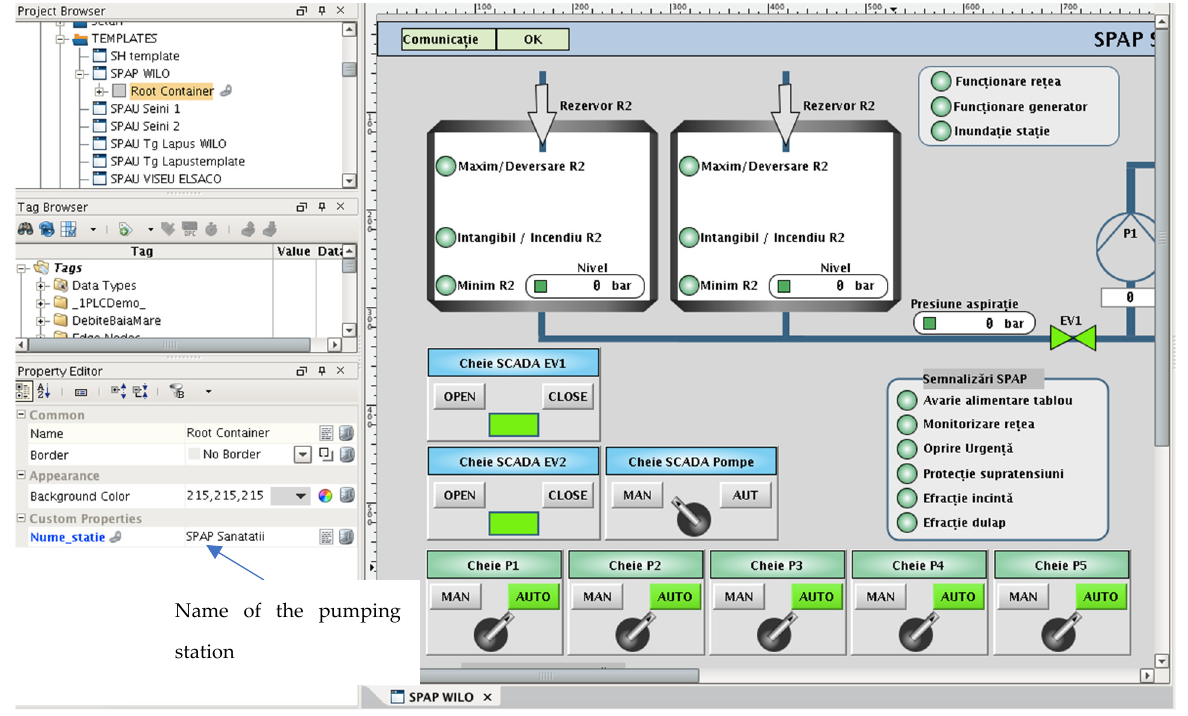
Figure 8. Dynamic template window for pumping stations.